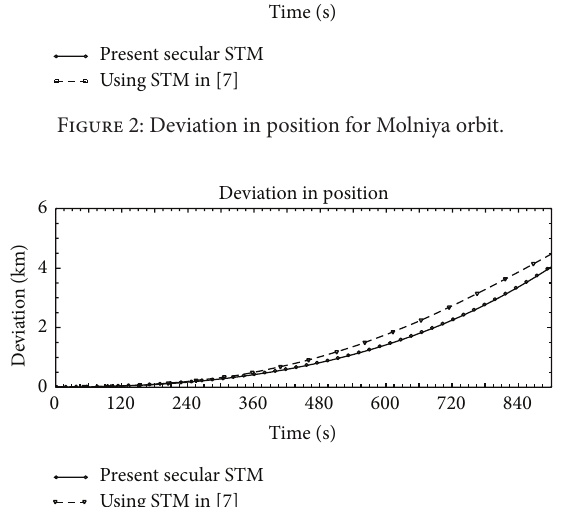
Figure 3: Deviation in position for sun-synchronous